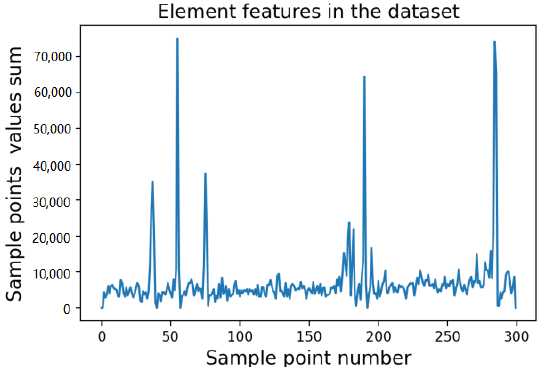
Figure 6. Distribution of data characteristics.